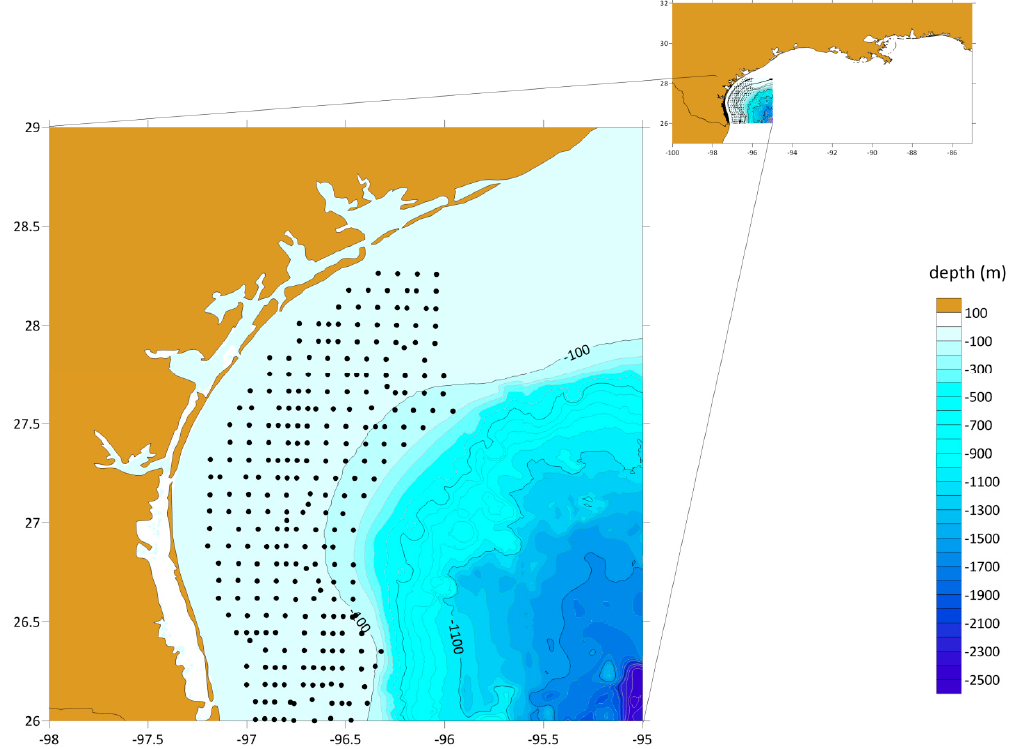
Figure 3. Sediment TOC collection sites off the Texas coast.